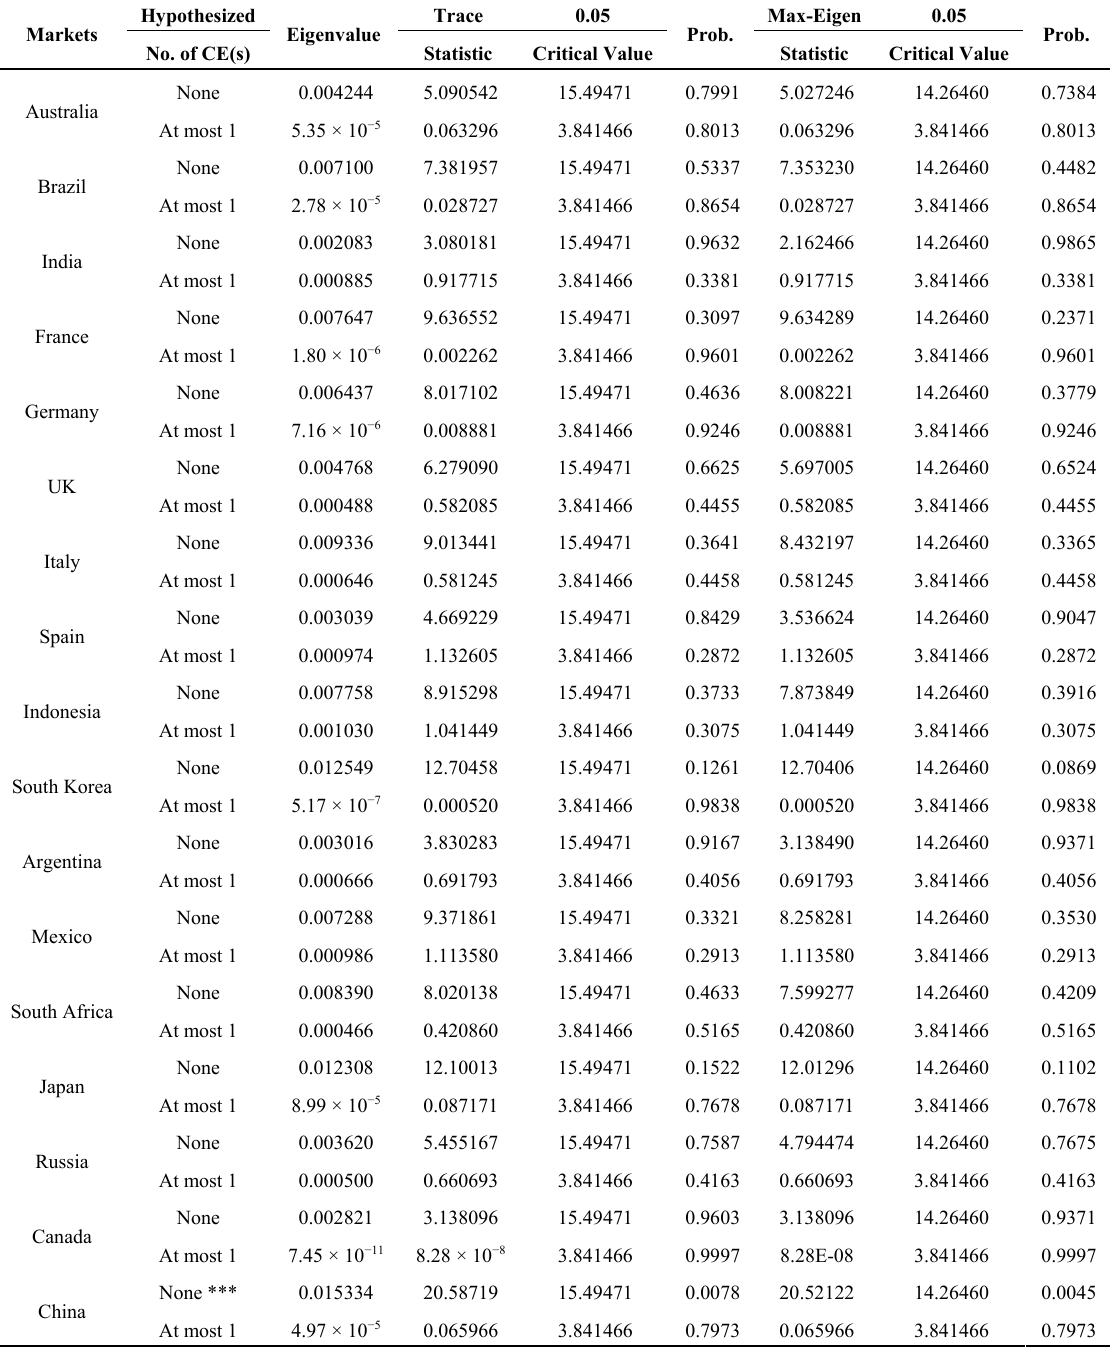
Table A9. Test for Johansen Cointegration in Sub-period